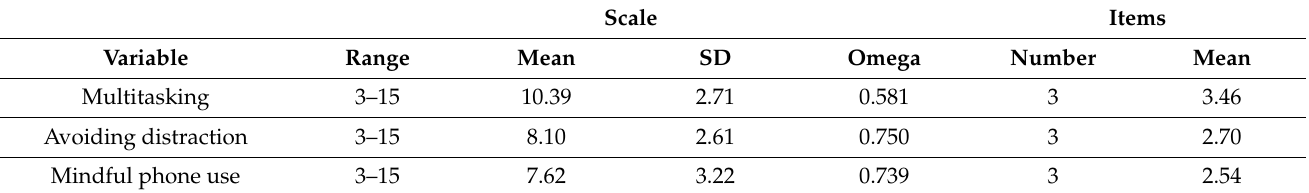
Table 4. Means, standard deviations, and internal consistency of common phone